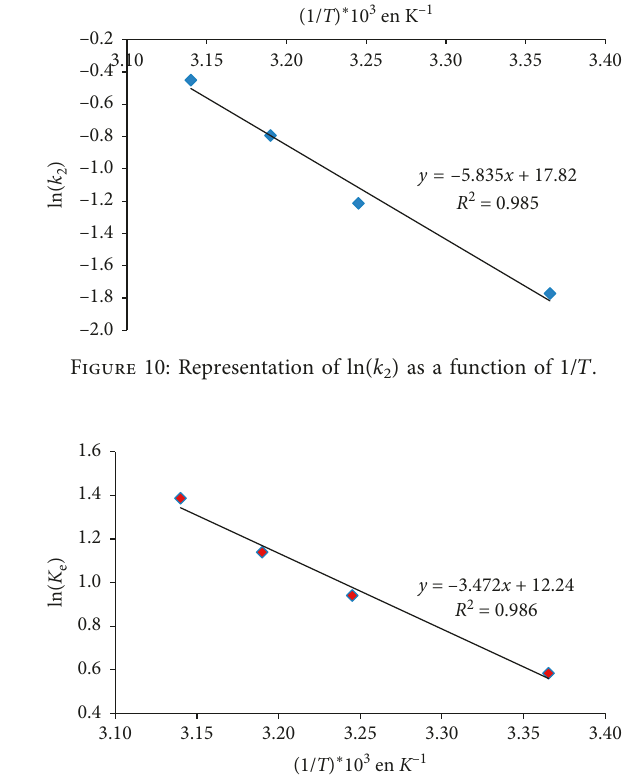
Table 3: Langmuir and Freundlich model parameters.